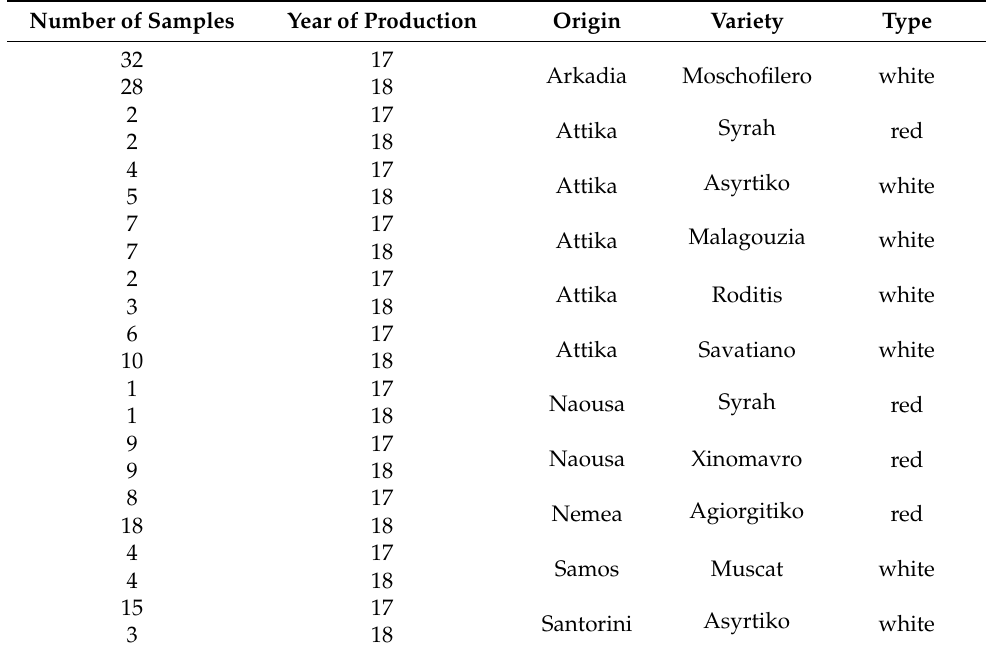
Figure 1. Hierarchical dendrogram for 44 chemical variables for the vintage year 2017. The clustering led to the following 4 significant clusters: K1 (K, Tl, Os, Au, Se, Pd, Ba, P, Mg, B, Fe, Sr), K2 (Ca, Cu, Na, V, Li, Co, Mn, Cr, Ni, Zn, Sn, Te, La, Pb, Sb), K3 (Tm, Hg, Al, As, Ag, Cd), and K4 (Be, Ga, Zr, Yb, Sm, Ho, Th, U, Ti, Nb, W). Table 1. An overview of the Greek wine samples (number of samples, vinification year, origin, variety, type of wine).